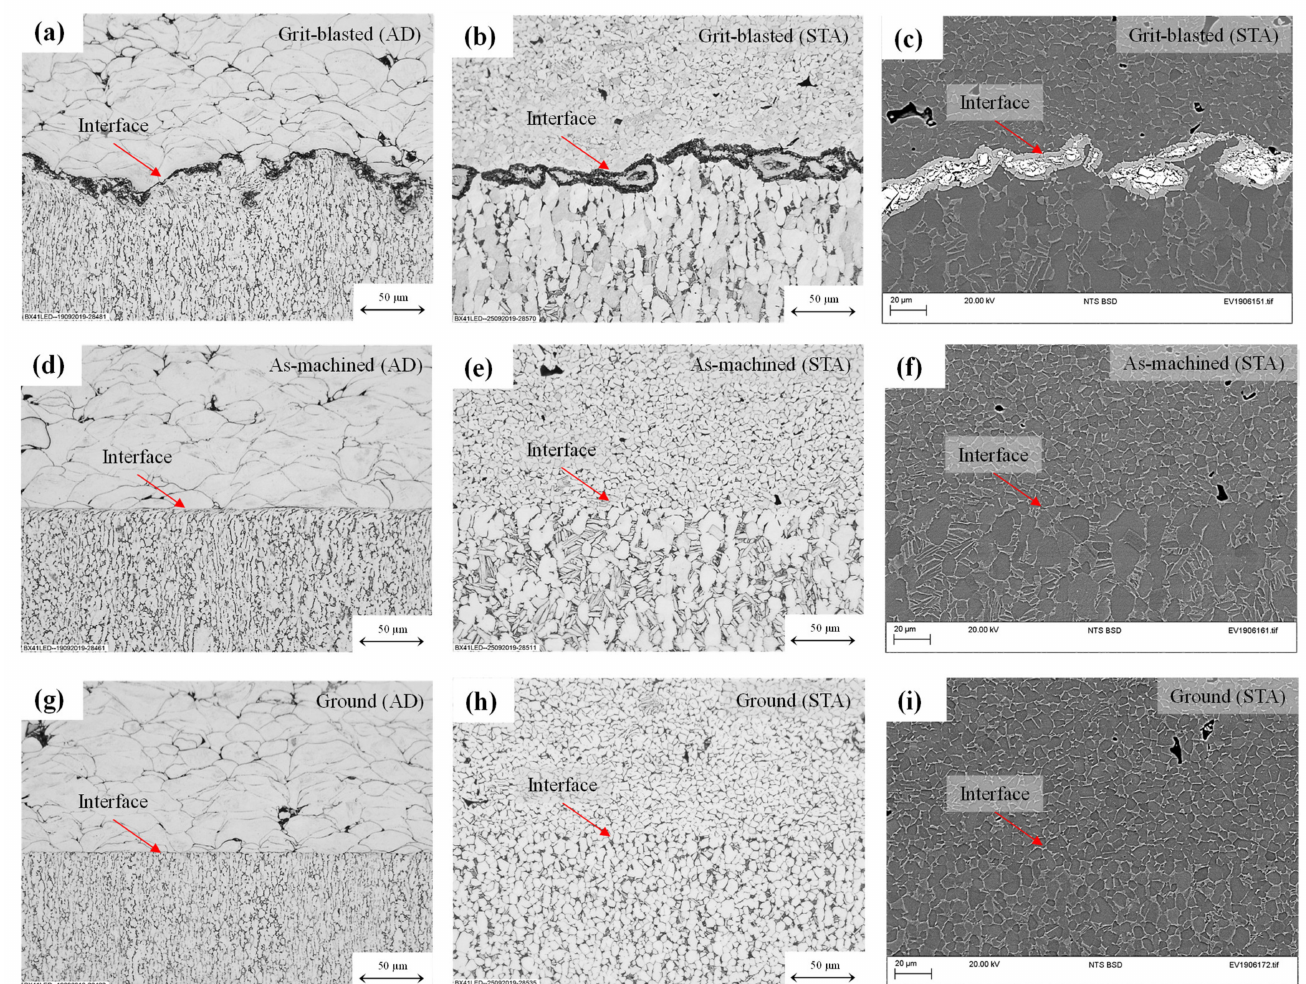
Figure 7. Cross-section microstructure images of the CS Ti6Al4V deposit/substrate interface, in as-deposited (AD) and solution treatment and aged (STA) conditions, with three different surface preparation conditions: ( a – c ) grit-blasted, ( d – f ) as-machined, ( g – i ) ground (of which ( a , b , d , e , g , h ) are optical micrographs), and ( c , f , i ) are SEM images. ( a , d , g ) are adopted from